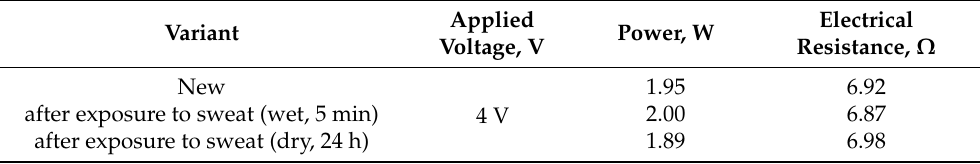
Table 8. Electrical properties of heating insert (variant B) after exposure to sweat.